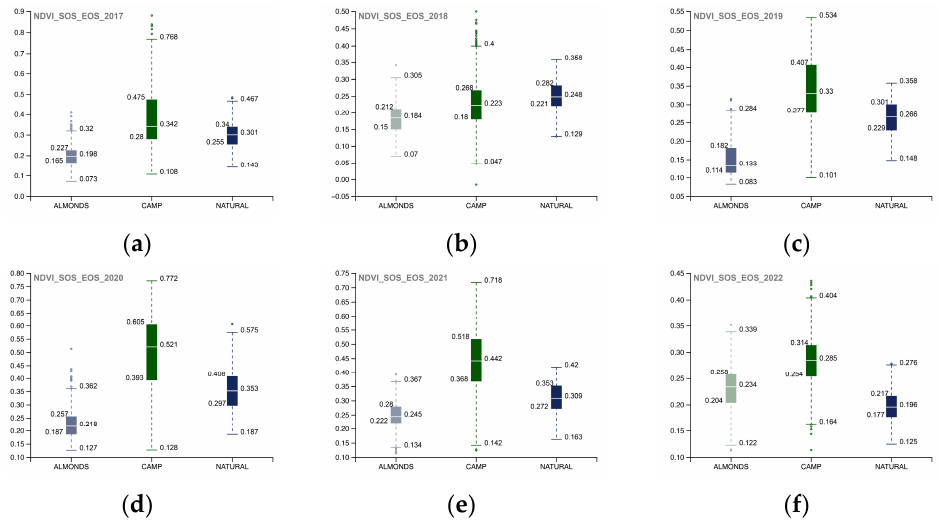
Figure 12. The yearly boxplots summarize NDVI SOS ‐ EOS quantitative distribution values and compare each portion of the AOI (01_REGENERATIVE_ALMONDS.shp; 02_CAMP_ALTIPLANO.shp; 03_NATURAL_AREA.shp) with five standard statistics: the smallest value, lower quartile, median, upper quartile, and largest value. Here, the comparison allows for yearly analysis of the cumulated values of each portion of the AOI, specifically (a) 2017, (b) 2018, (c) 2019, (d) 2020, (e) 2021, (f) 2022. Landscape restoration actions of the Camp_Altiplano area stand out, tangibly proving the outputs of the ecosystem restoration methodologies.